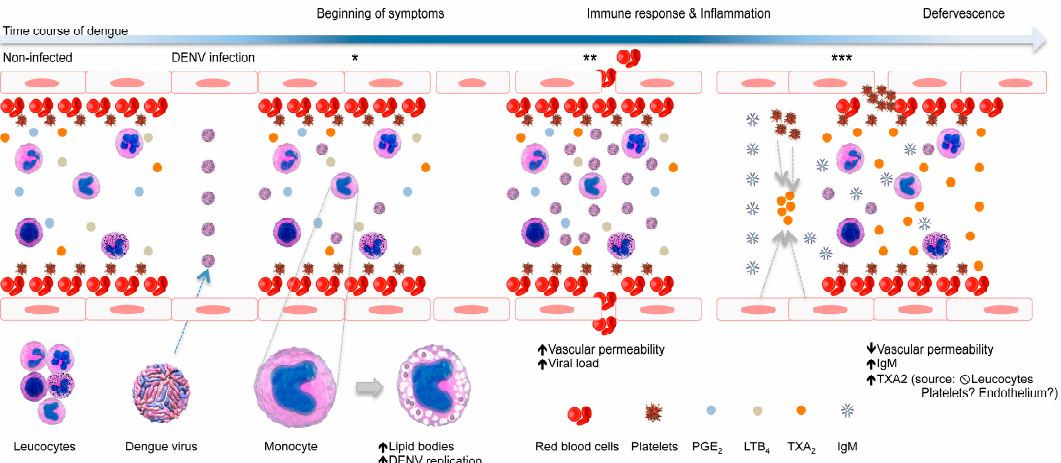
Figure 5. Schematic model of the role of LB and TXA 2 in dengue prognosis. During the time course of DENV infection, the virus triggers morphological and functional changes in monocytes, increasing the amount of LBs and vacuoles, which may be optimal sites of viral replication (*). Further, a high viral load and an unbalanced immune response could lead to the onset of dengue symptoms, including vascular damage with plasma leakage and bleeding (**). However, after seroconversion, characterized by the production of IgM, high levels of TXA 2 are produced, putatively by platelets and/or endothelial cells, which may trigger vasoconstriction and platelet aggregation, preventing the intense vascular leakage and bleeding observed in severe dengue cases (***).